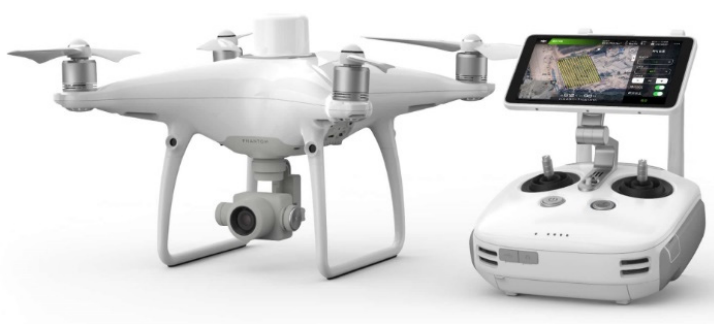
Figure 2. Phantom 4 RTK in a UAV.